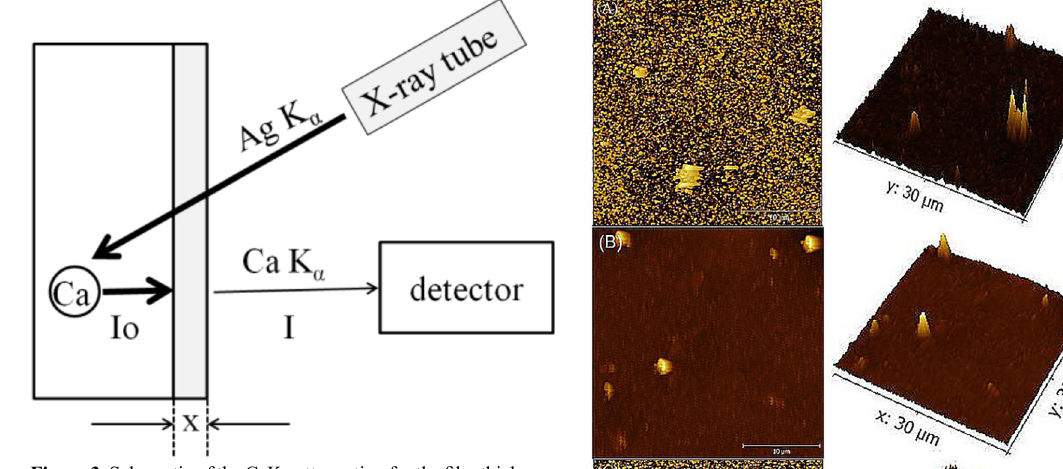
Figure 3. Schematic of the CaKα attenuation for the film thickness measurement. Table 1. Thickness of V the calcium Kα line. Sample